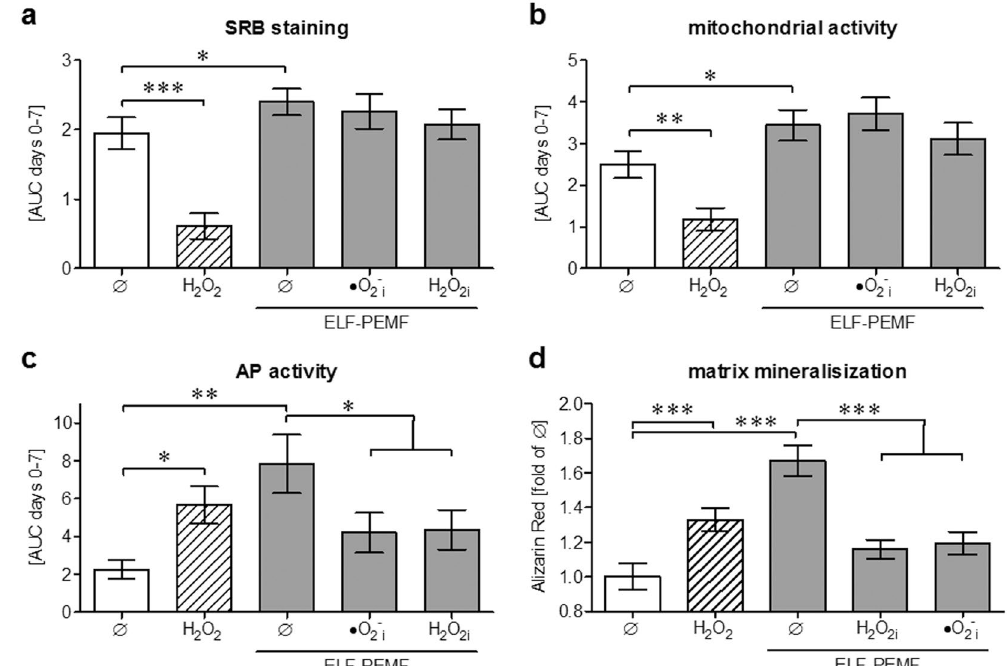
Figure 5. ROS induction is necessary to improve the osteogenic function of hOBs by ELF-PEMF. HOBs (N = 12, n = 4) were osteogenically differentiated with or without daily exposure to ELF-PEMF. To simulate oxidative stress cells were stimulated with 0.001% H 2 O 2 (shaded bars). To trap the ROS ELF-PEMF exposed hOBs were co- incubated with either 25 µ M α -tocopherol ( • O 2 − i ) or 10 mM sodium-pyruvate (H 2 O 2i ). ( a – c ) On days 0, 2, 4 and 7 total protein content (SRB staining), mitochondrial activity (Resazurin conversion) and AP activity were measured. Results are given as AUC (area under the curve) from day 0 to day 7. ( d ) After 14 days the formed mineralized matrix was quantified by Alizarin Red staining. Data are given as fold of unstimulated cells. * p < 0.05, ** p < 0.01 and *** p < 0.001 as indicated (Kruskal-Wallis test followed by Dunn’s multiple comparison test, α =